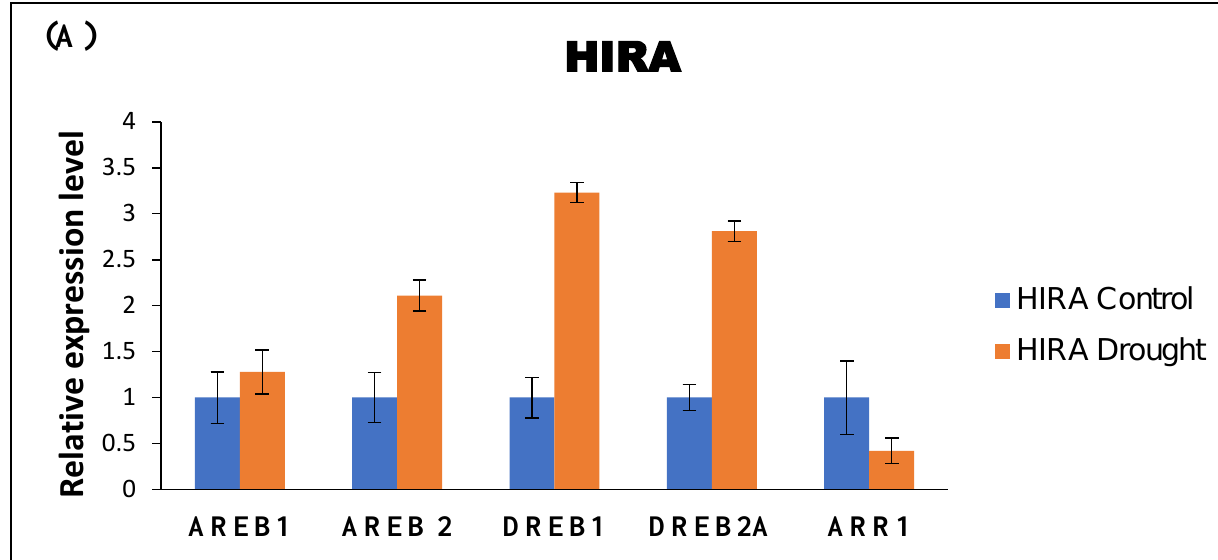
Table 4. Computation of stability scores for combinations of two RGs for flax qRT-PCR gene ex- pression study. The best pair of RGs was obtained by calculating an individual stability score using NormFinder. The groups are the combination of flax cultivars Hira (H), Mukta (M), and R552 (R). Best Combination of Two Stability Score Group Genes EF1a and ETIF5A 0.010 EF1a and Actin 0.016 HMR ETIF5A and Actin 0.018 EF1a and ETIF5A 0.009 EF1a and Actin 0.011 HM ETIF5A and Actin 0.019 EF1a and ETIF5A 0.012 EF1a and Actin 0.021 MR ETIF5A and Actin 0.021 EF1a and ETIF5A 0.006 EF1a and Actin 0.014 HR ETIF5A and Actin 0.026 The identified DRGs in flax were used for obtaining the qRT-PCR expression data after imparting drought stress. The expression profiling of all five DRGs were computed by relative quantification using EF1a as a reference gene. The results suggest that AREB2 has a higher expression while ARR1 has the lowest uniform expression (Figure 3A) in all three cultivars. It was further observed that DREB1 and DREB2A have higher expression in Hira, whereas they are antagonistically expressed in Mukta and R552 cultivars (Figure 3). In Mukta, DREB1 exhibited 0.2-fold lower expression while DREB2A recorded a 0.3-fold higher expression (Figure 3B). Surprisingly, DREB1 exhibited 0.2-fold lower expression while DREB2 exhibited 20-fold higher expression in the R552 genotype (Figure 3C).